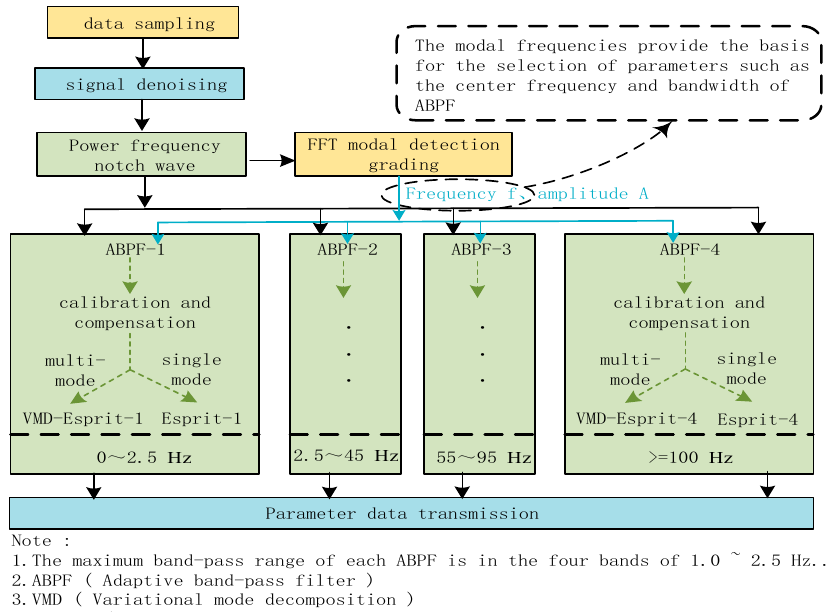
Figure 1. Flow chart of the broadband electromagnetic oscillation multi-mode monitoring